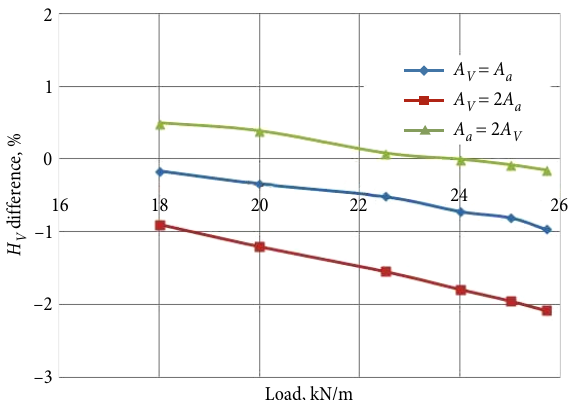
Load, Fig. 4. The difference between thrust force calculations of the upper cable in the middle of the stress-ribbon structure with external tendon span in percent